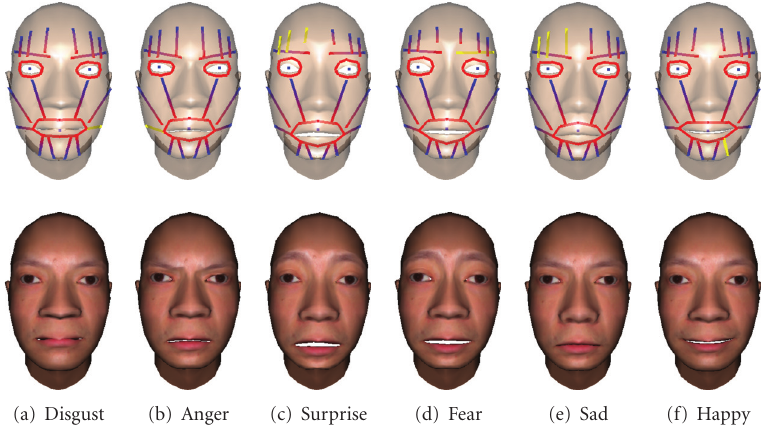
Figure 10: Six canonical facial expressions by muscle